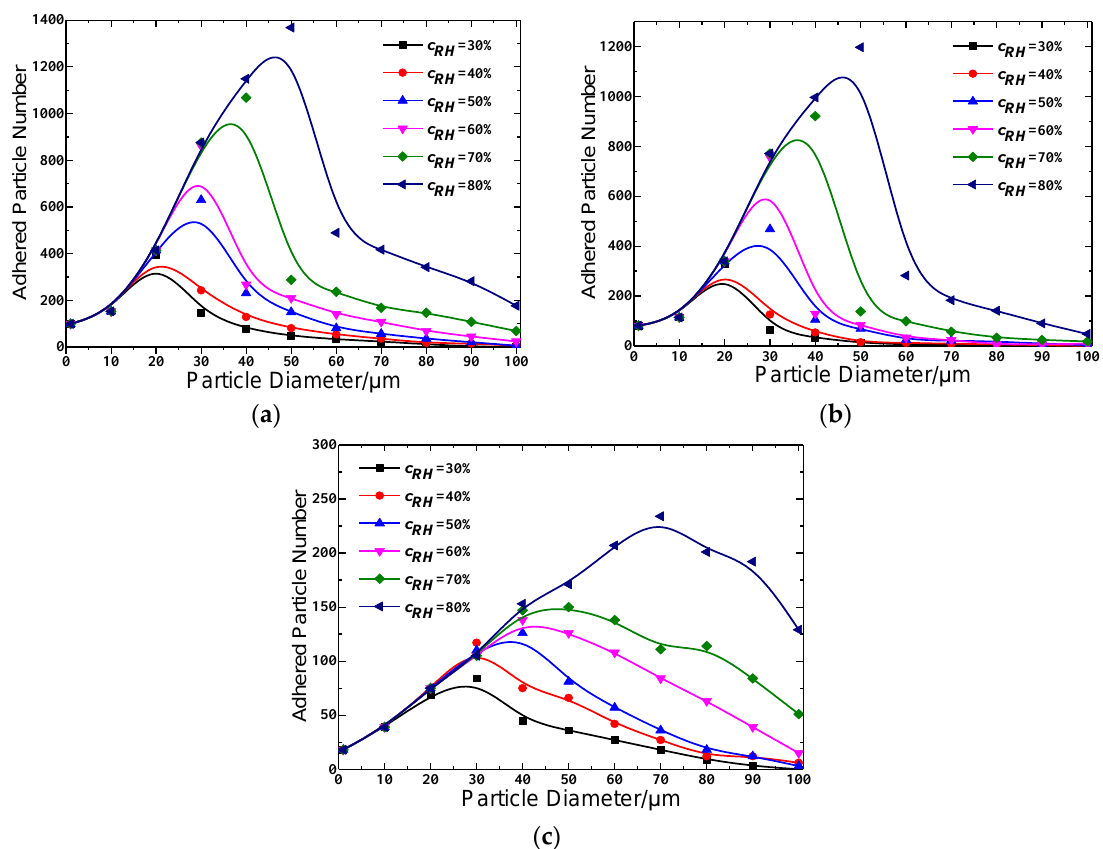
Figure 5. Adhesion number of particles with different size under different relative humidity: ( a ) all surface; ( b ) upper surface; and ( c ) bottom surface.